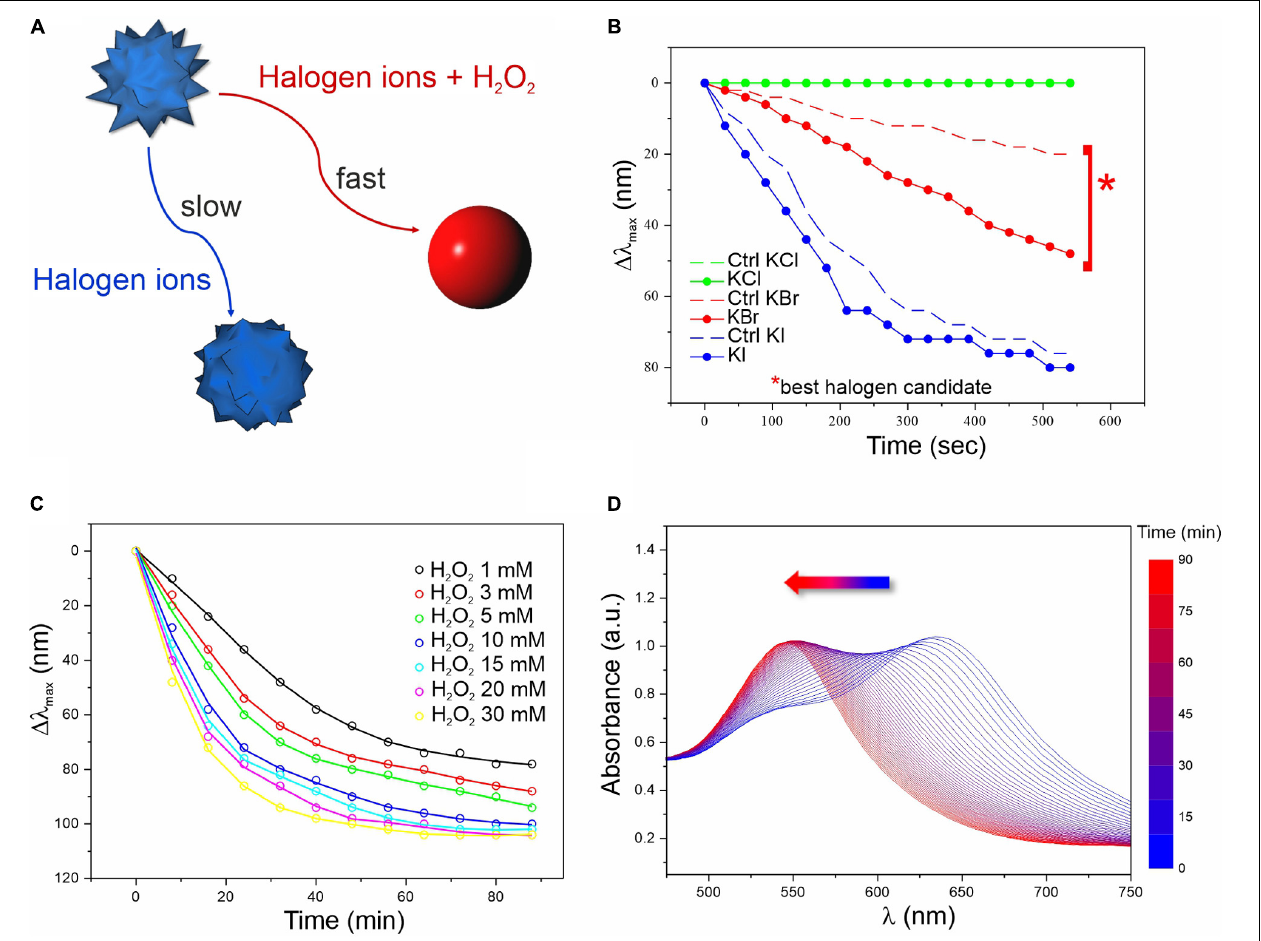
FIGURE 1 | Screening of the chemical conditions for the colorimetric assay. (A) Schematics of the reactions involved in the MGNP morphological changes in water. (B) LSPR λ max evolution over time related to MGNP reaction with H 2 O 2 (3 mM) in presence of optimized concentrations of different halogens (more info in Supplementary Material ). Control (Ctrl) performed in absence of H 2 O 2 . (C) LSPR λ max evolution of MGNPs exposed to Br − (5 mM) with increasing H 2 O 2 concentration (1–30 mM). (D) Absorption spectra related to the MGNP reshaping process for optimized reaction conditions (see Supplementary Material ). All reactions were carried out at pH =